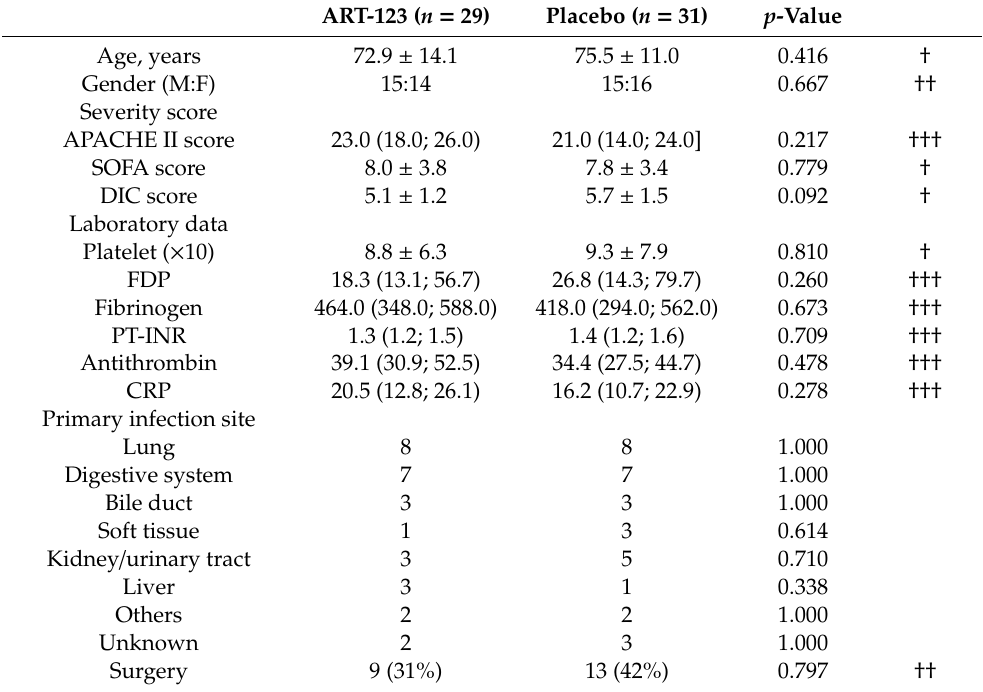
Table 3. Baseline clinical